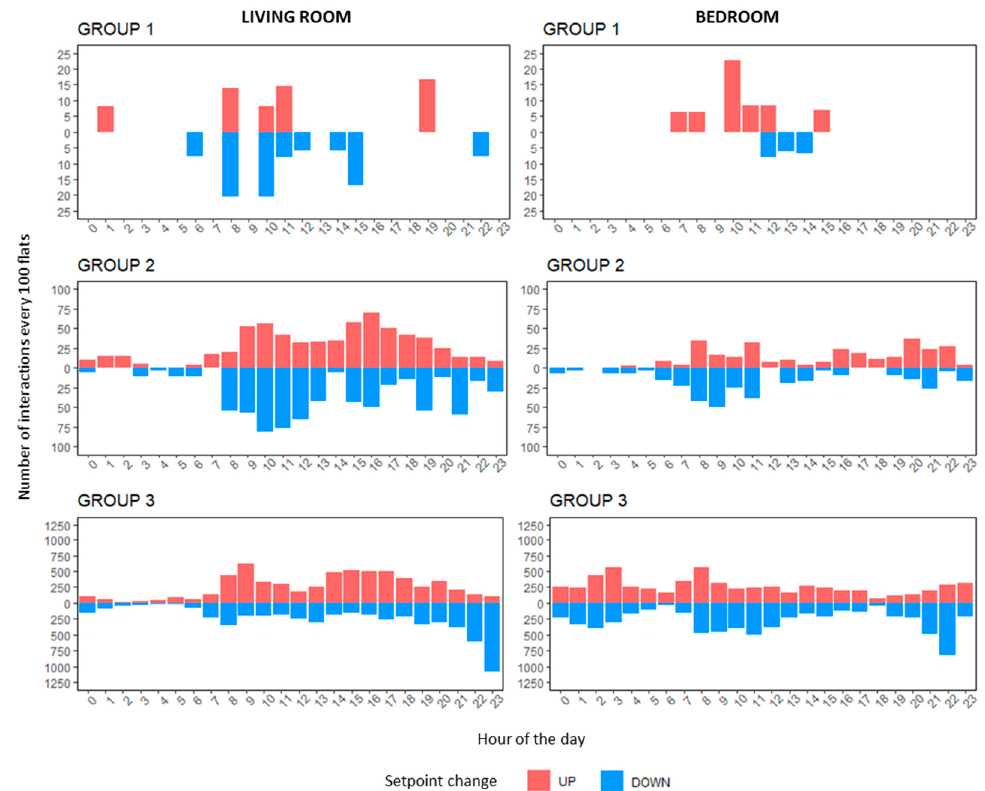
Figure 8. Twenty-four-hour profile of interactions with smart thermostatic valves by group. Results are scaled to 100 flats to compare across groups and rooms. The number of interactions were weighted by the number of observations of each flat for the monitoring period (March 2019 to April 2020). Note that each graph has a different scale range, due to the contrasting number of interactions in each group.